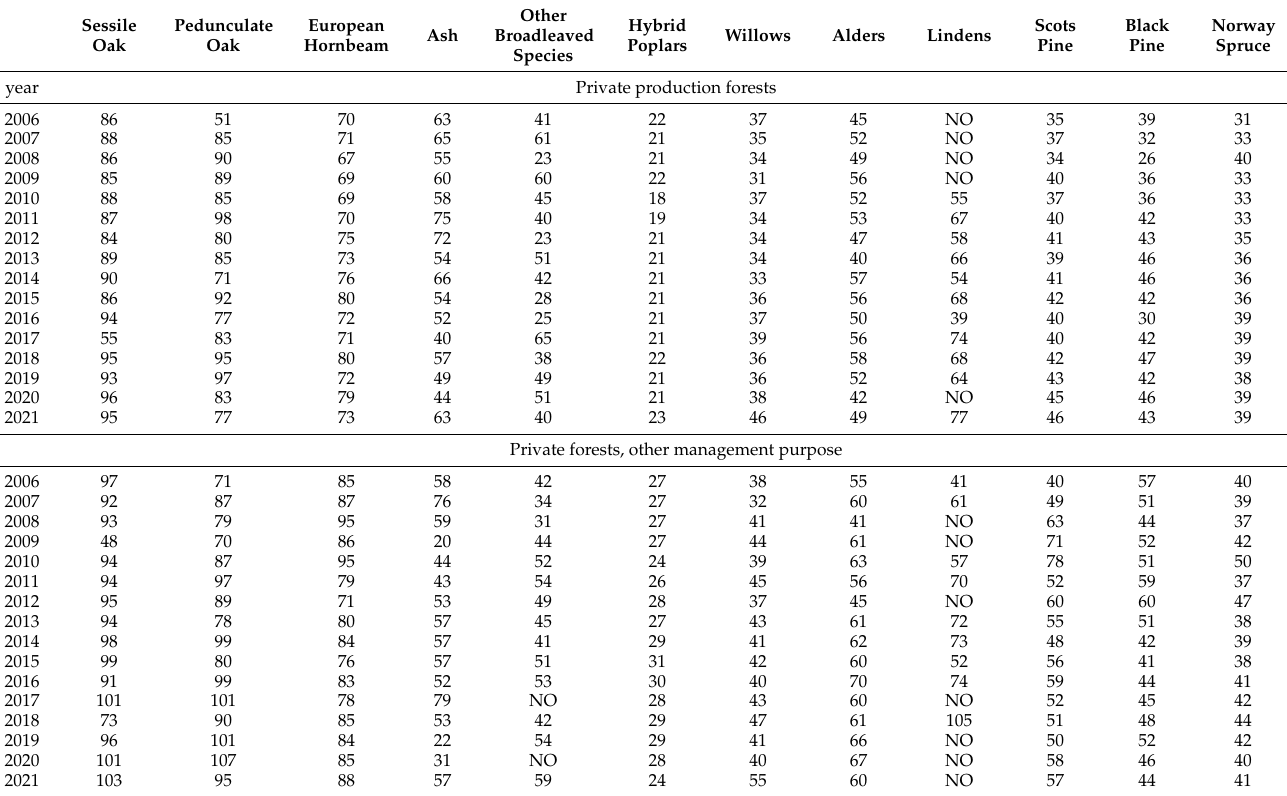
Table A1. Harmonic mean of harvesting ages (weighted by the area under harvest) of some examined tree species and tree species groups in the period between 2006 and 2021, grouped by management purpose and ownership. (In the table, ‘NO’ indicates that in the given year no harvest took